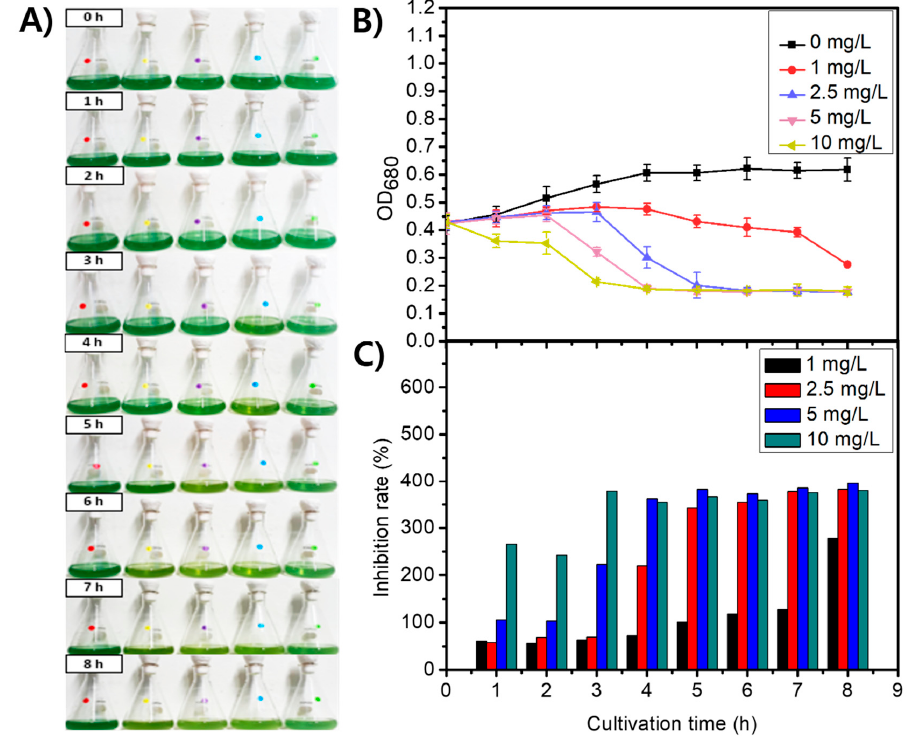
Figure 5. Growth inhibition of M. aeruginosa by MoZnO with time. ( A ) Change in pigment of M. aeruginosa suspension. ( B ) Change in OD680 of M. aeruginosa , and ( C ) Inhibition rate (%) of M. aeruginosa . Statistical significance (determined by paired t -test) is shown by * = p < 0.05, ** = p < 0.001, *** = p < 0.0001, when compared to control (0).